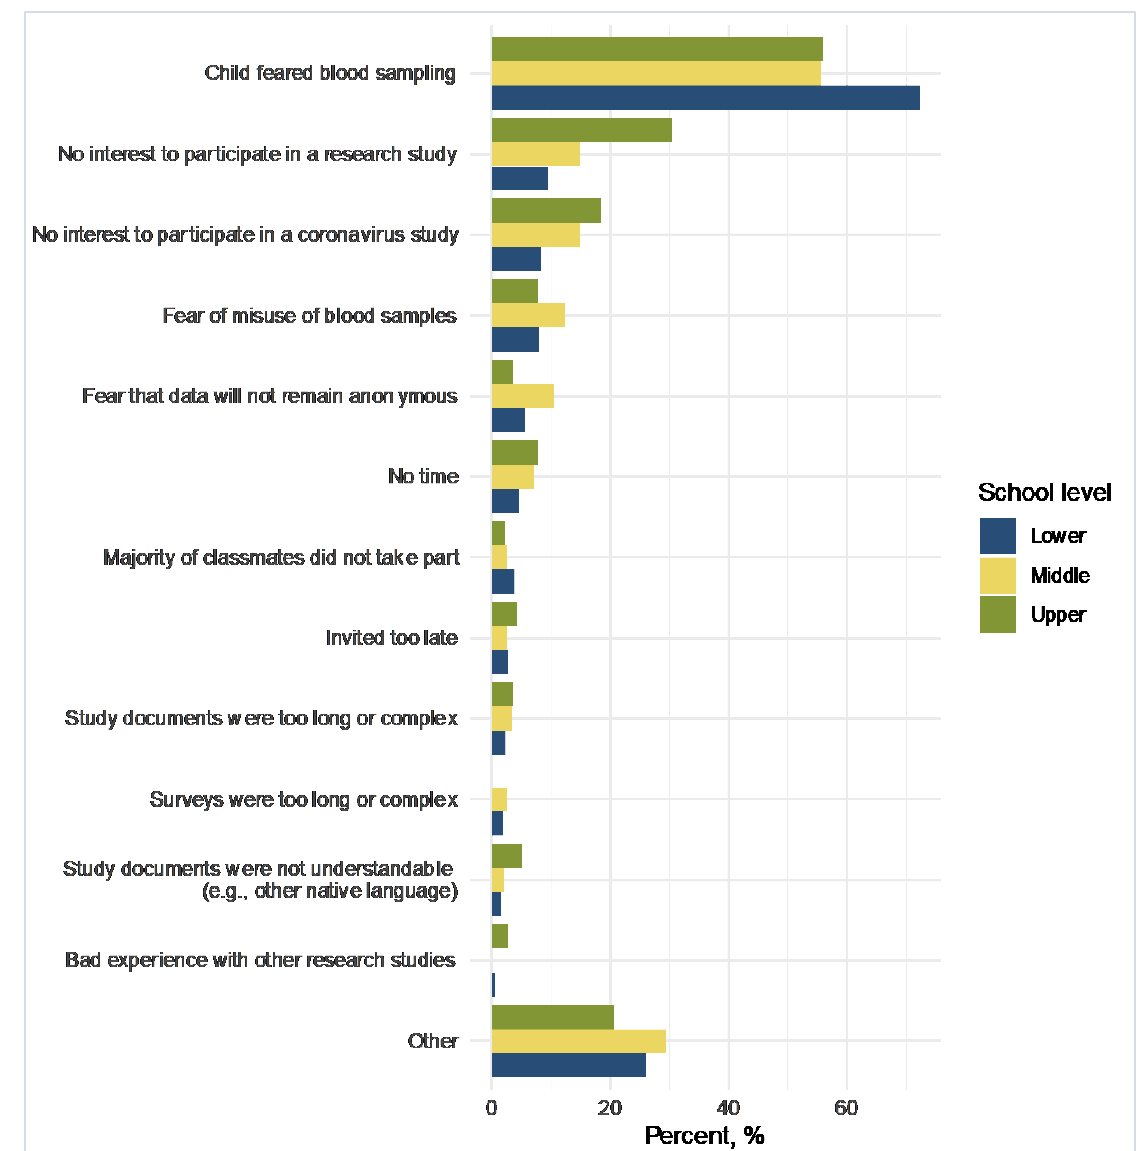
Figure 2S Reasons for non-participation in the Ciao Corona study assessed during the third round of assessment in March/April 2021 among 567 eligible participants according to the school level (e.g. lower=grades 2-3, middle=grades 5-6, upper=grades 8-9). Multiple answers were allowed for the 13 pre-defined reasons